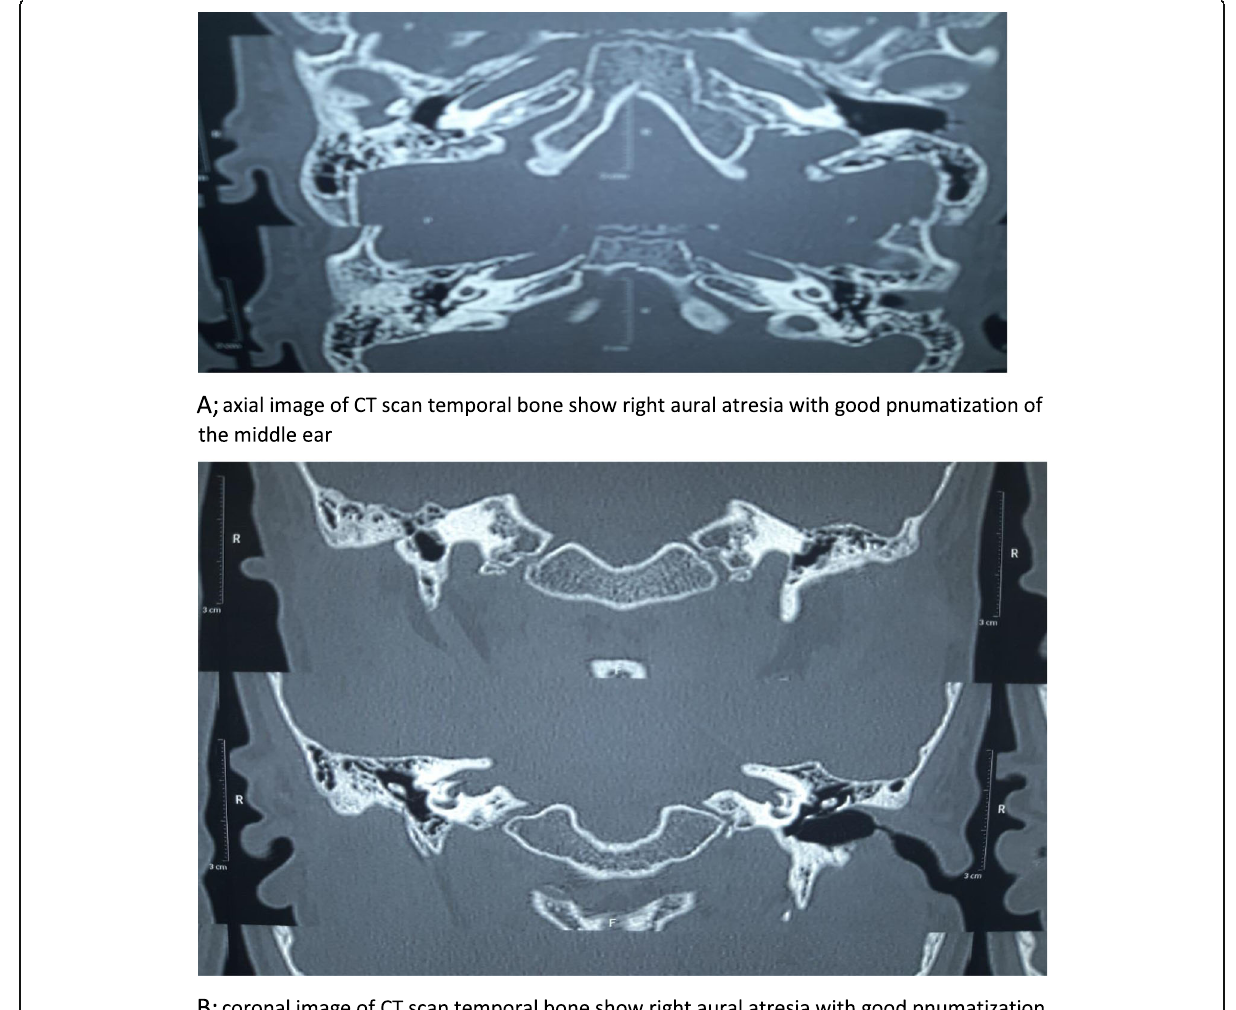
Fig. 1 CT scan, coronal and axial view show atresia of the right ear. A Axial image of CT scan temporal bone shows right aural atresia with good pneumatization of the middle ear. B Coronal image of CT scan temporal bone show right aural atresia with good pneumatization of the middle ear and the